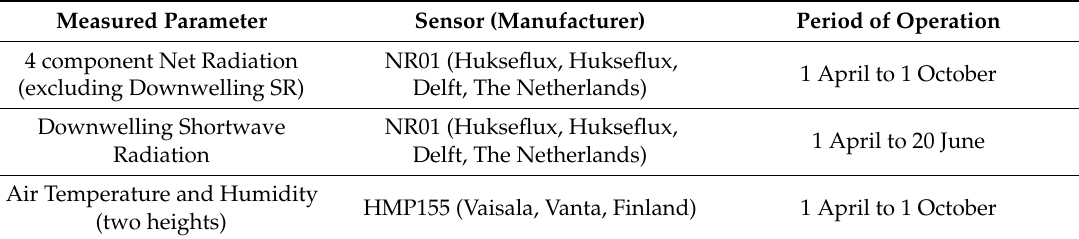
Table 1. Sensors from 2015 Field Experiment used in this